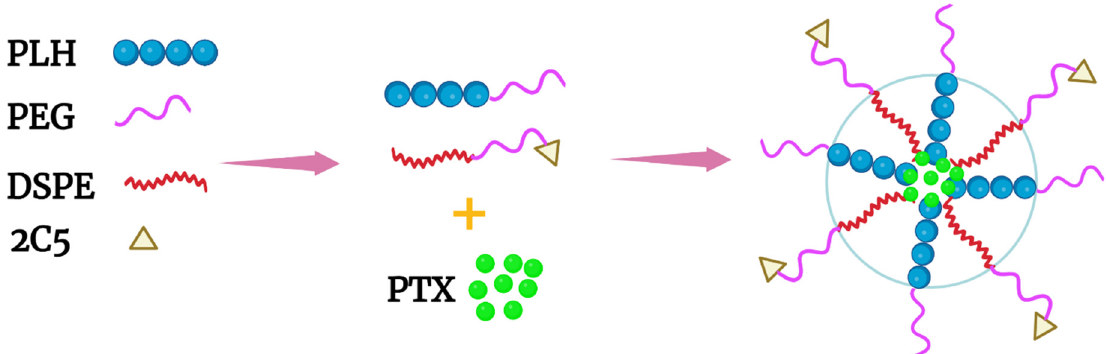
Figure 3. Schematic of a mixed micelle formed with the copolymers PEG-PLH, PEG-DSPE, and 2C5-PEG-DSPE. The hydrophobic drug PTX was incorporated within the inner core, which comprised PLH and DSPE.